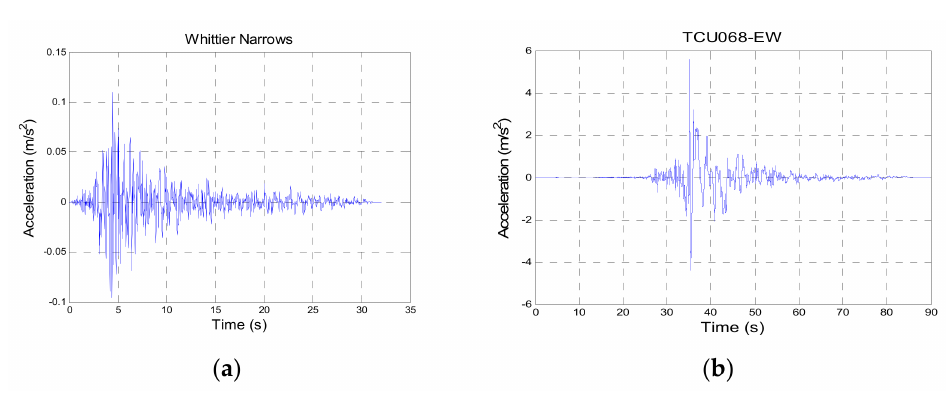
Figure 2. Input time–history data for theoretical simulation. ( a ) Whittier Narrows-01. ( b ) Chi-Chi